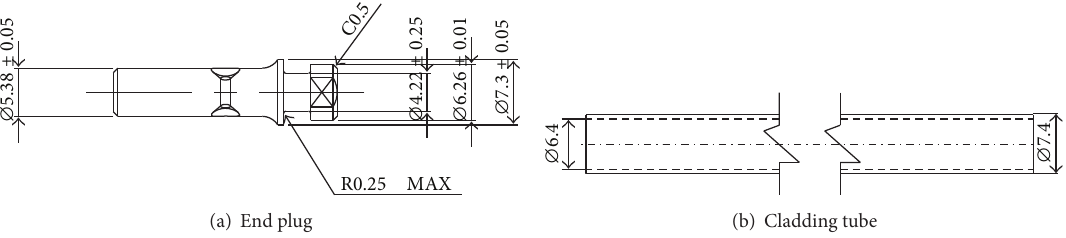
Figure 8: Weld joint design for SFR fuel end plug welding.